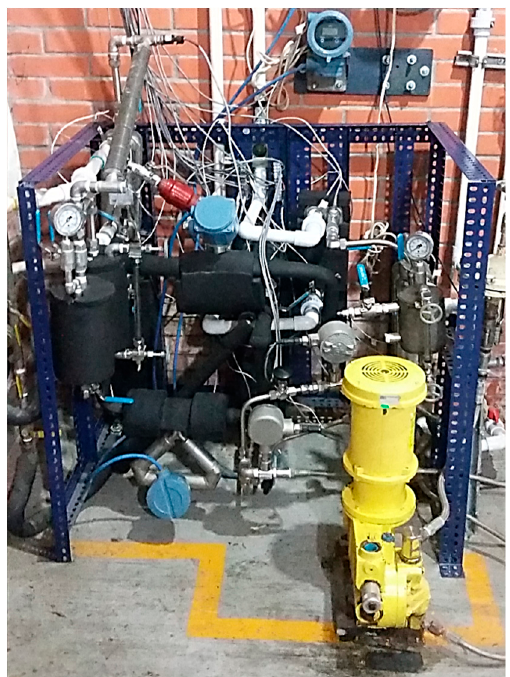
Figure 3. Developed absorption cooling machine.